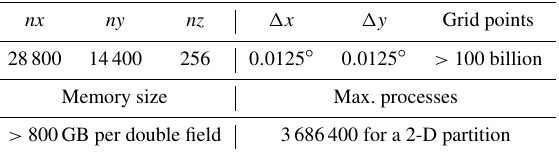
Table 3. A three-dimensional grid for assessing the communication of the atmospheric model. (cid:49)x and (cid:49)y are given as if this grid is a uniform global longitude–latitude grid. In fact, this grid resembles the grid of a regional spectral atmospheric model or the uniform longitude–latitude grid used by some global models. nx